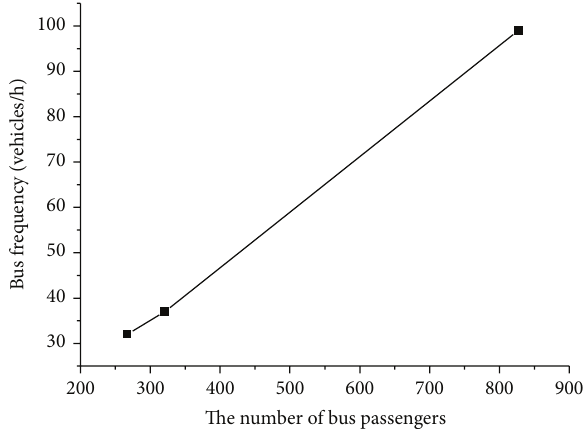
Figure 2: The effect of the number of bus passengers on the bus